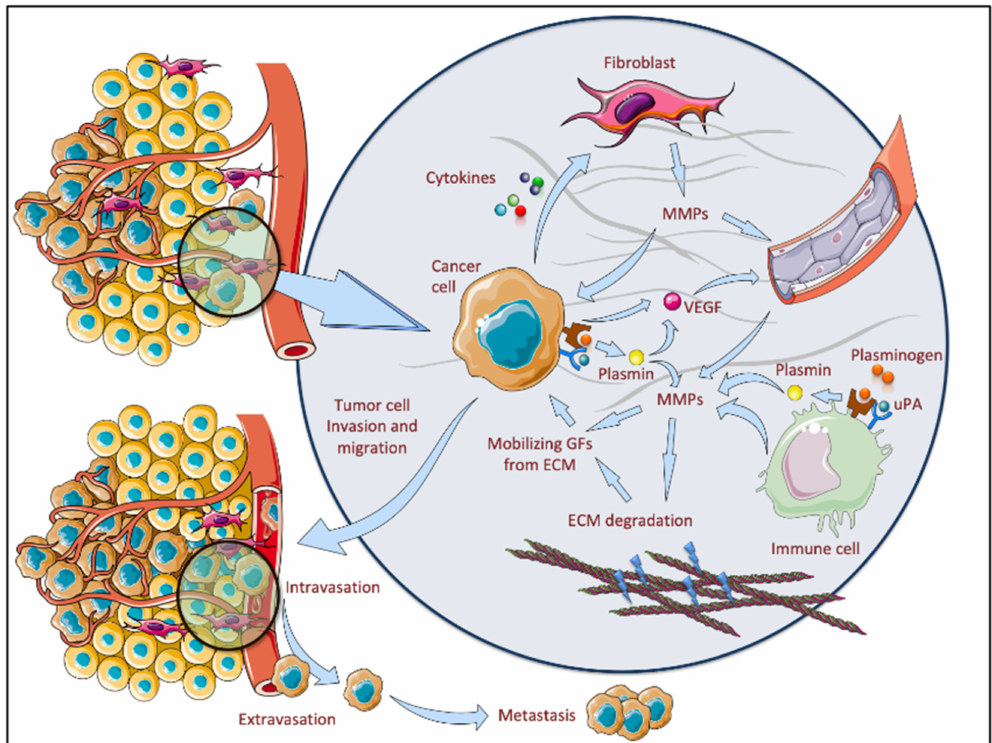
Figure 1. The interplay between MMPs and the tumor microenvironment. In the tumor microenvironment, MMPs are released by fibroblasts and immune cells, as well as by tumor cells. Plasminogen binds to its receptors and is converted to plasmin by urokinase plasminogen activator (uPA). In turn, plasmin may activate various MMPs and certain growth factors. All these molecules create a suitable microenvironment for ECM degradation, tumor cell invasion and